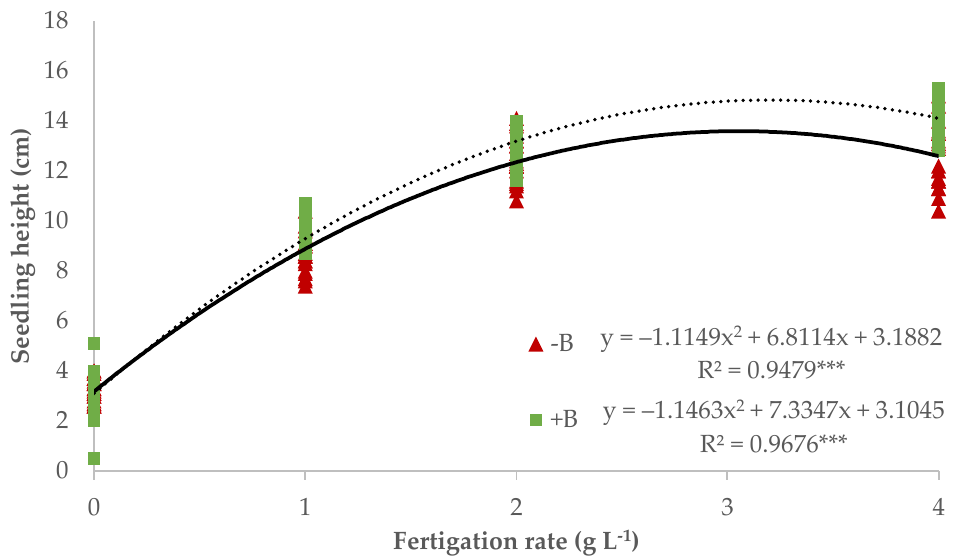
Figure 1. Quadratic predictions of the relationship between fertigation rate (g L − 1 of NPK 20-20-20) and height values of lettuce seedlings not inoculated (-B, continuous line) or inoculated (+B, dotted line) with a bacterial biostimulant (*** significant at p < 0.001).